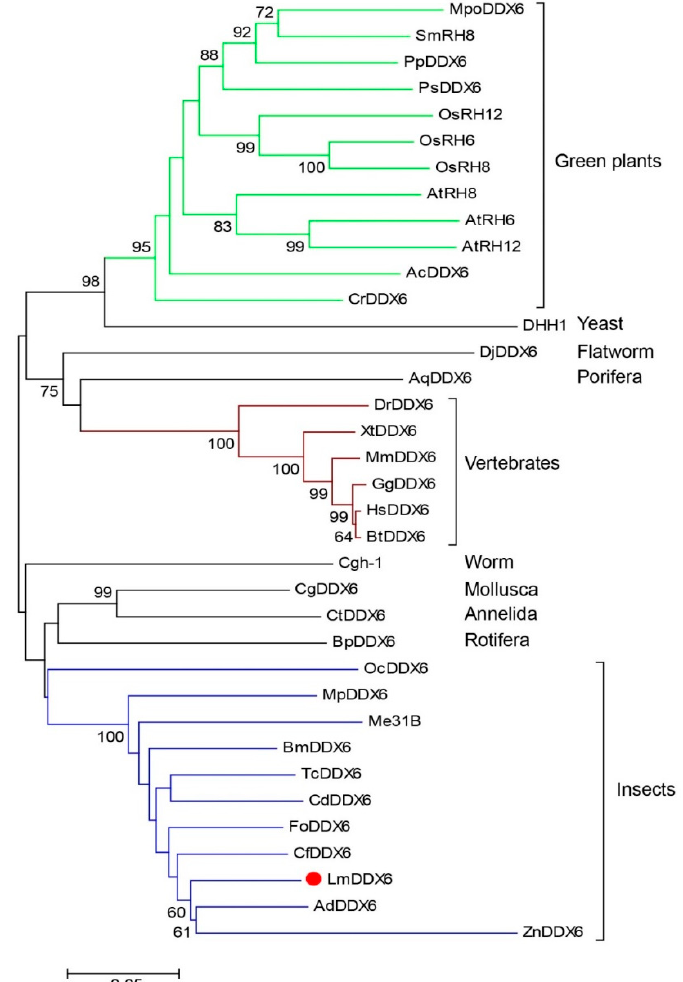
Figure 2. A phylogenetic tree of DDX6 orthologs. DDX6 protein sequences from different species were obtained from NCBI (National Center for Biotechnology Information), and a multiple-sequence alignment was performed using ClustalW software. The phylogenetic tree was generated by MEGA 6 using neighbor-joining method with 1000 repetitions. The filled, red circle indicates DDX6 from L. migratoria . Protein accession numbers are shown in Table 1.